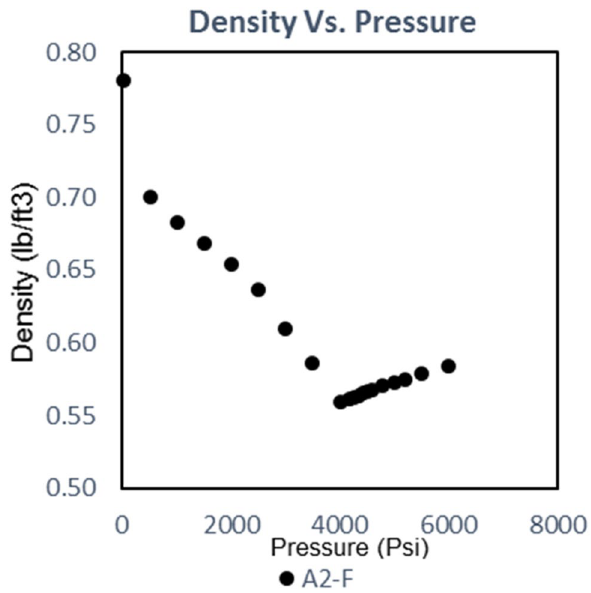
Fig. 9 Valid trend of oil density of A2-F sample—DL test